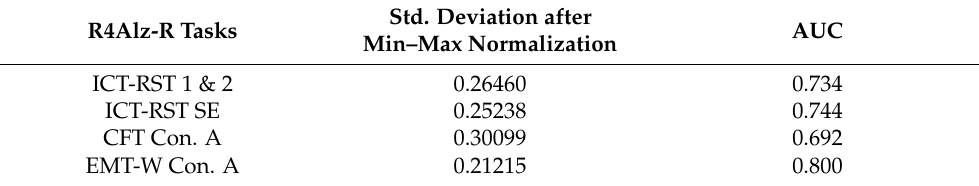
Table 7. Standard deviations of the R4Alz-R battery’s scores of interest for SCD and MCI groups. Std. Deviation after R4Alz-R Tasks